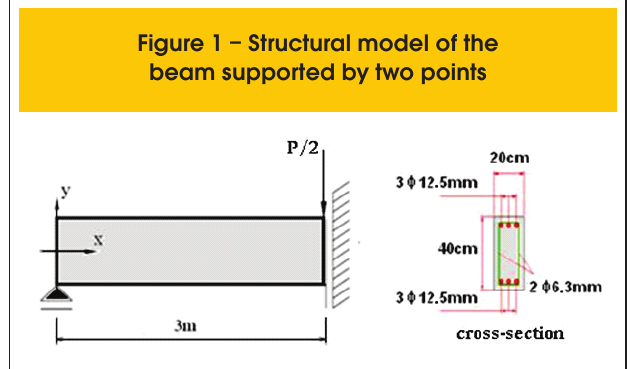
Figure 1 – Structural model of the beam supported by two points